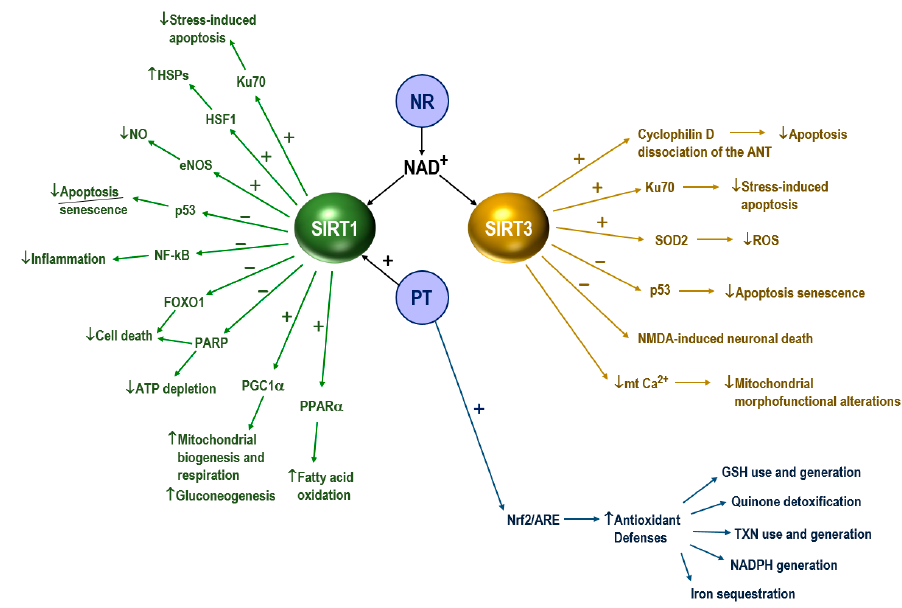
Figure 1. Molecular interactions underlying the effect of nicotinamide riboside (NR) and pterostilbene (PT) in amyotrophic lateral sclerosis (ALS). SIRT1, sirtuin 1; SIRT3, sirtuin 3; HSPs, heat ‐ shock proteins; HSF1, heat ‐ shock factor 1; NF ‐ kB, nuclear factor kappa ‐ light ‐ chain ‐ enhancer of activated B cells; FOXO1, forkhead box protein O1; PARP, poly (ADP ‐ ribose) polymerase; PGC1 α , peroxisome proliferator ‐ activated receptor gamma coactivator 1 ‐ alpha; LXRs, liver X receptors; eNOS endothelial nitric oxide synthase; PPAR α , peroxisome proliferator ‐ activated receptors alpha; Nrf2/ARE,